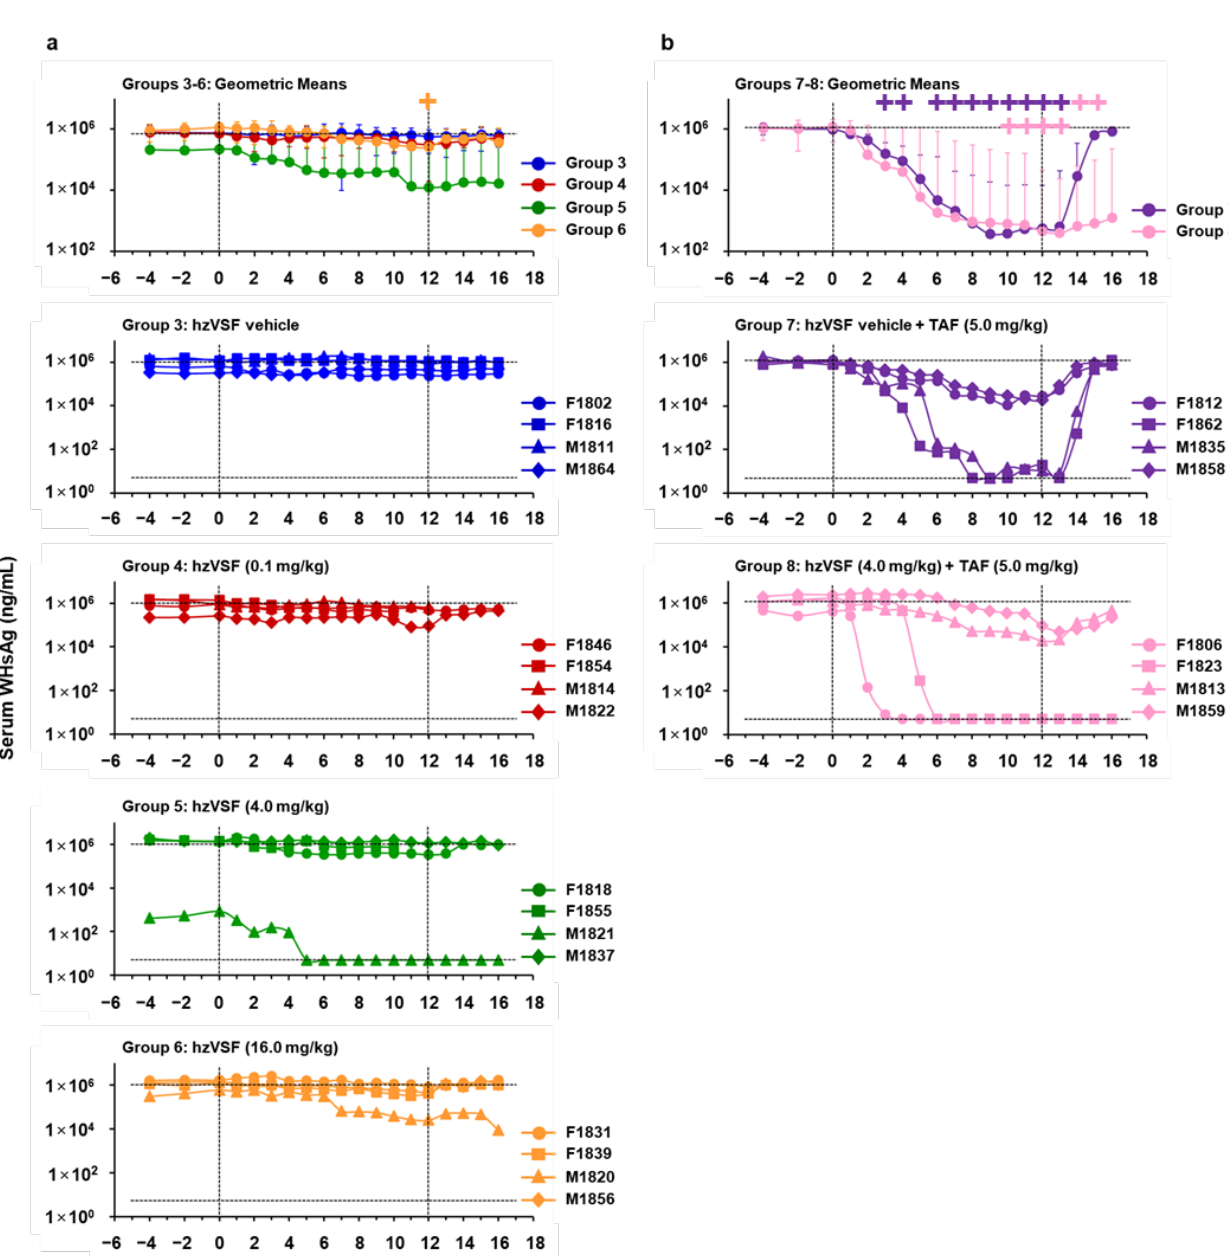
Figure 8. hzVSF monotreatment modestly reduces serum surface antigenemia, but suppression is enhanced in combination with TAF. Changes in serum WHsAg levels relative to the pretreatment baseline (T0) of individual woodchucks treated with ( a ) placebo or hzVSF at a low, intermediate, and high dose and ( b ) TAF, alone or in combination with hzVSF at an intermediate dose. The top panels present the changes in the group geometric means of all mono and combination treatment regimens and the vertical lines indicate the standard error of the mean. The upper horizontal dotted lines present the mean antigenemia level of Groups 3 – 6 or Groups 7 – 8 at baseline, while the lower horizontal dotted lines indicate the detection limit for WHsAg (i.e., 5 ng/mL). Antigenemia in Group 6 was significantly reduced compared to the baseline at week 12 (+: p < 0.05). Compared to the baseline, antigenemia in Group 7 and Group 8 was significantly reduced at weeks 3, 4, 6 – 13, and 15 or during weeks 10 – 15, respectively (+: p < 0.05). Based on the observation that the hzVSF-mediated antiviral effect was enhanced in one animal in the setting of low WHV replication (i.e., M1821 of Group 5), additional chronic WHV carrier woodchucks were treated with TAF for a rapid suppression of viral